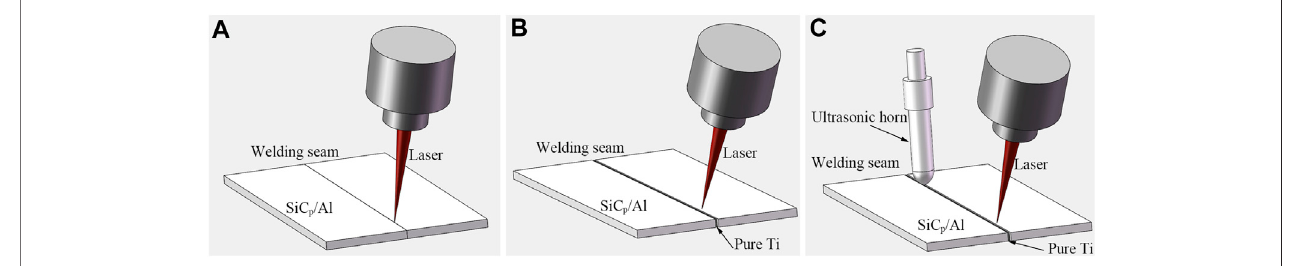
FIGURE 2 | Schematic diagram ofthree welding processes: (A) direct laser welding (B) laser welding with Ti interlayer (C) Ultrasonic-assisted laser welding with Ti interlayer.